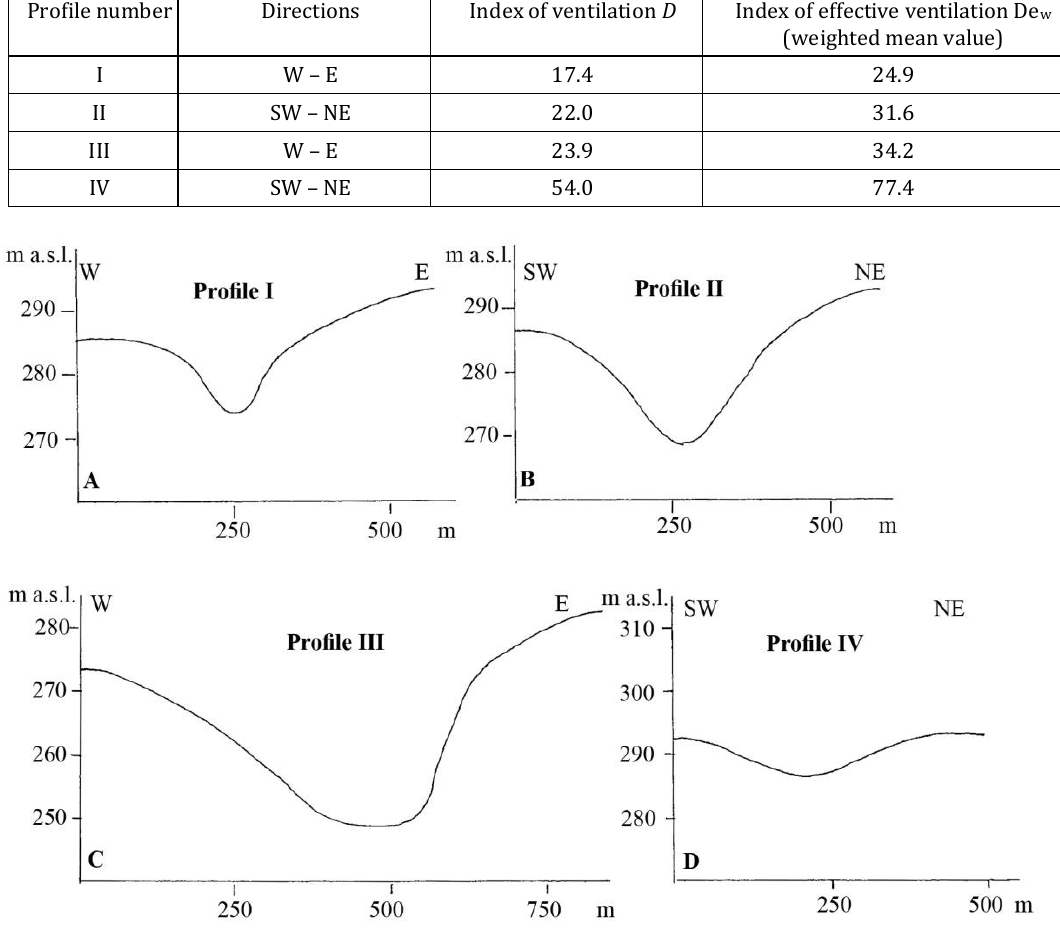
Fig. 1. Examples of transverse profiles through the Szotkówka and Pszczynka